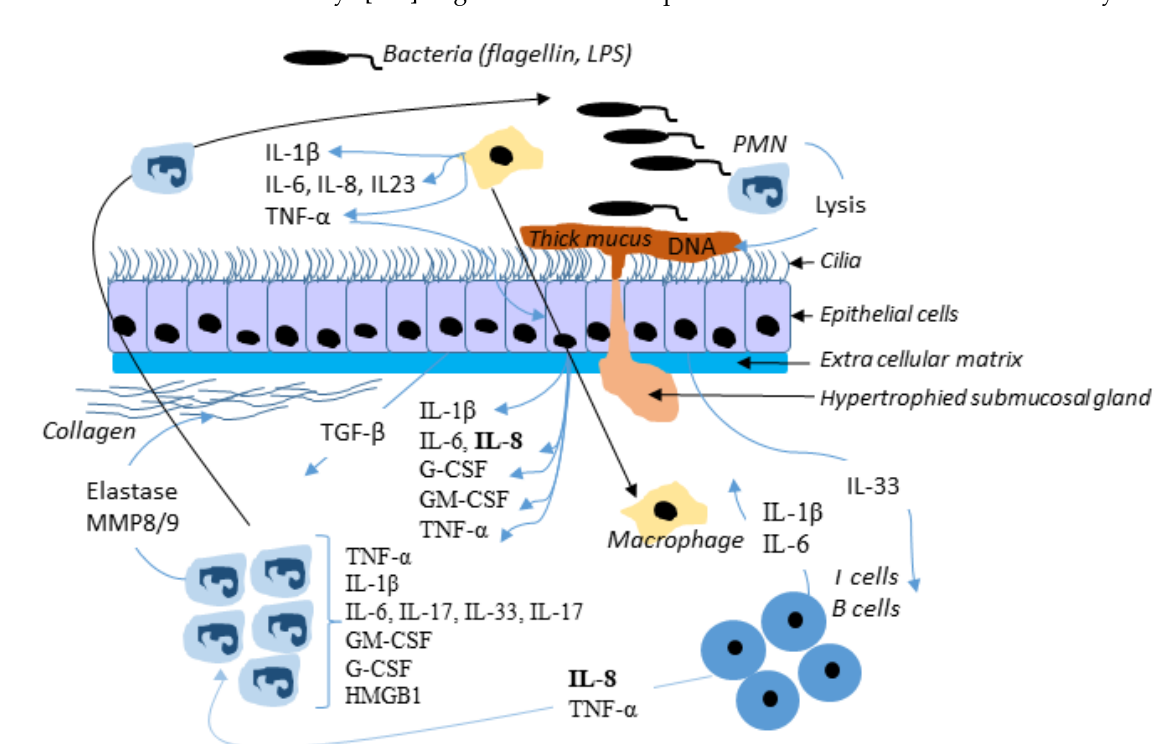
Figure 4. Simplified view of infection in the CF airway. In response to bacterial invasion, neutrophils migrate from submucosal regions through airway epithelial cells to reach airway lumen, where they encounter with pathogens and secret inflammatory mediators and release proteases and oxidants. This damage the airway and chemoattractants stimulate further neutrophil influx. Although the neutrophil and epithelial cell and their mediators have been most intensely studied, many other cells, including dendritic cells, T-lymphocytes, B-lymphocytes, macrophages, and airway smooth muscle cells, produce inflammatory mediators and are actively involved in the host inflammatory response in CF. Not all mediators and cell types implicated in CF are shown here.